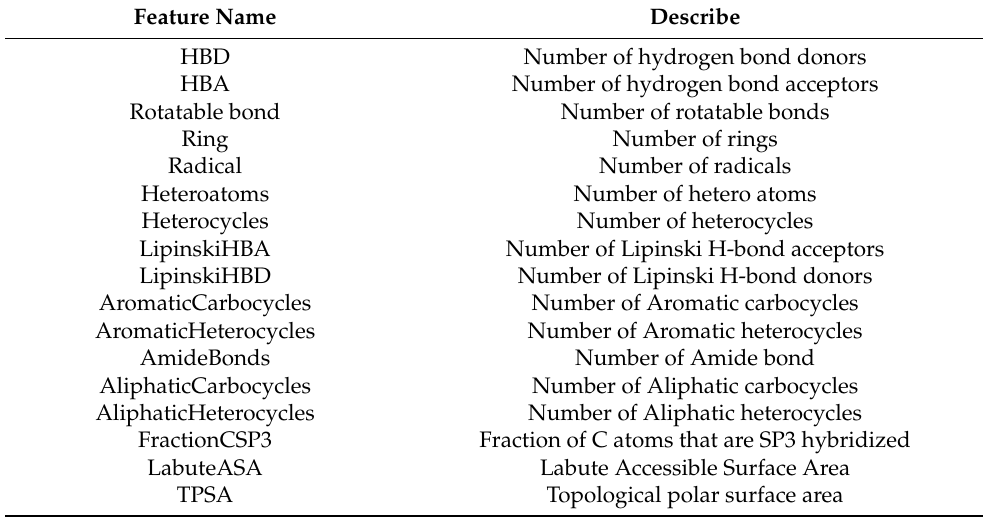
Table 1. Types of molecular